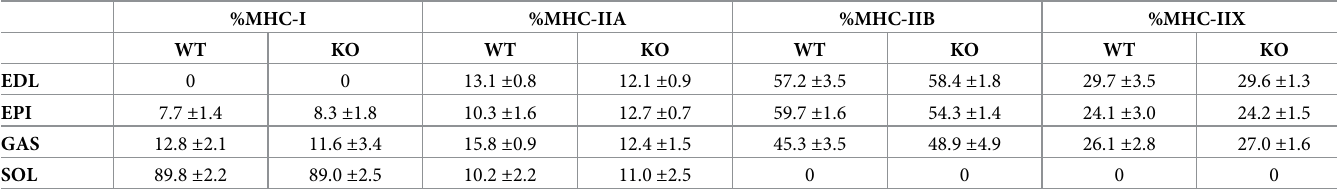
Table 2. Relative myosin heavy chain isoform composition of skeletal muscles.